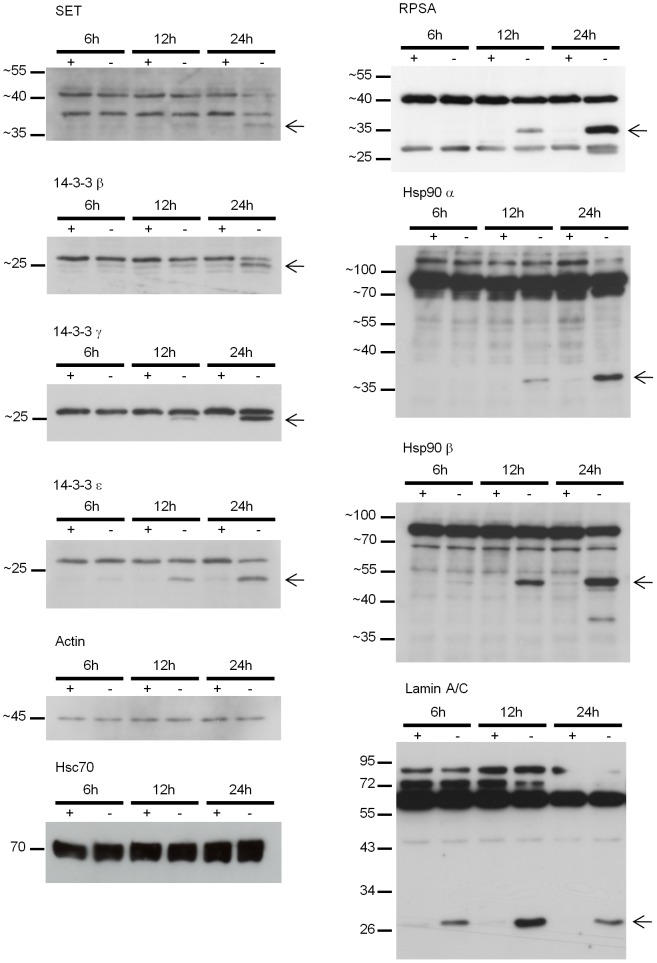
Western blot confirmation of protein proteolysis under SDL conditions.Western blotting of total cell lysates harvested from one independent culture after 6 hour, 12 hour and 24 hour in ESDL (+Epo) and SDL (-Epo) using antibodies against SET, 14-3-3 β, 14-3-3 γ, 14-3-3 ε, RPSA, Hsp90 isofoms alpha and beta. 20 µg of protein lysate was loaded per lane. Beta Actin and Hsc70 were used as loading controls. The arrows point to the smaller proteolytic fragments that occur in apoptotic erythroblasts.